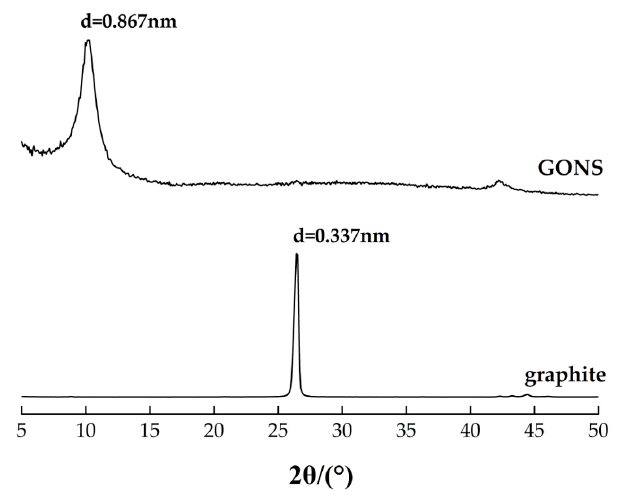
Figure 2. XRD patterns of GONS and graphite.